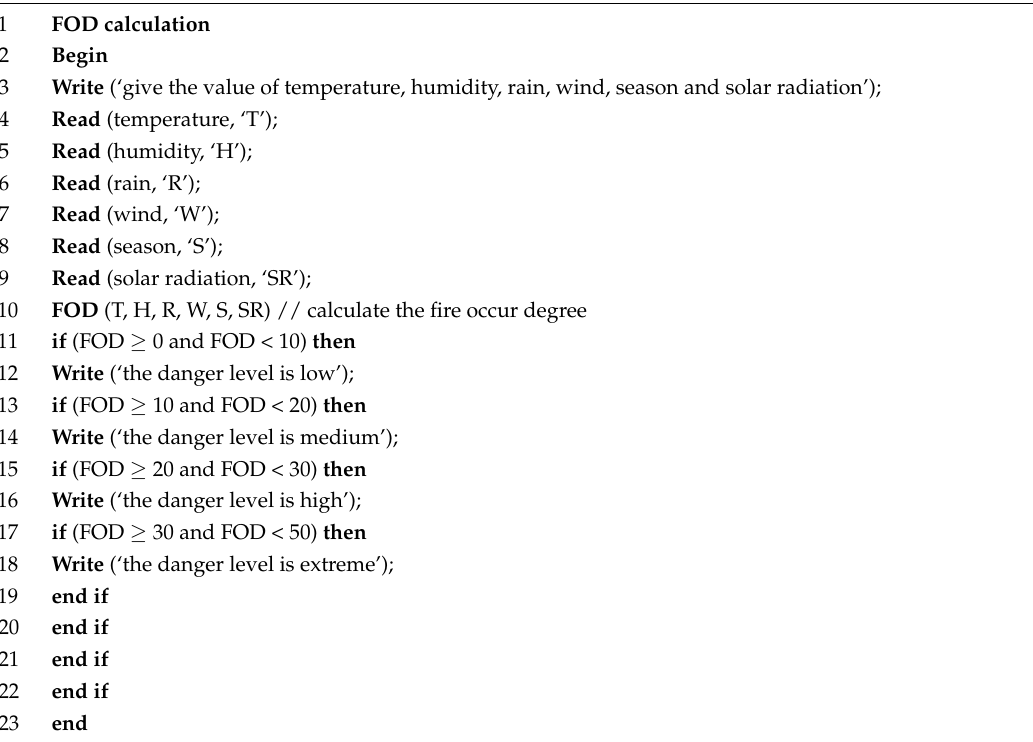
Algorithm 1. The pseudo-code of the algorithm to calculate